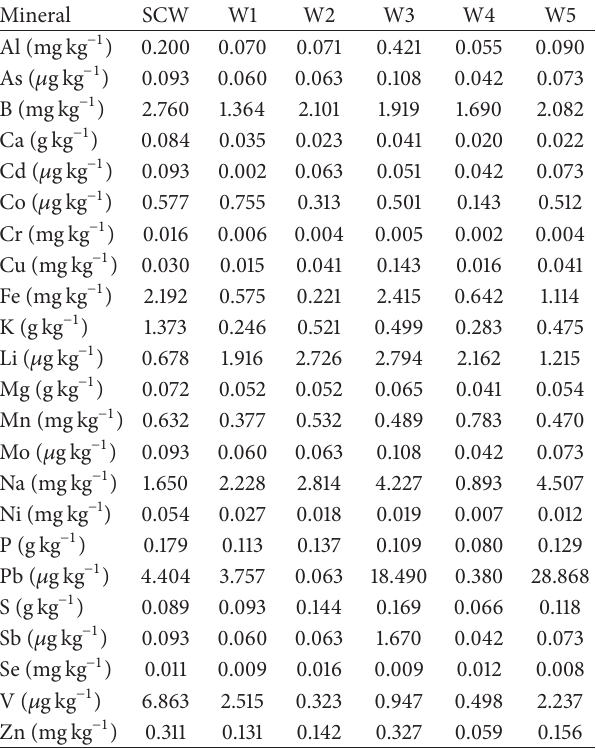
Table 5: The amounts of minerals in cherry wine and grape wine